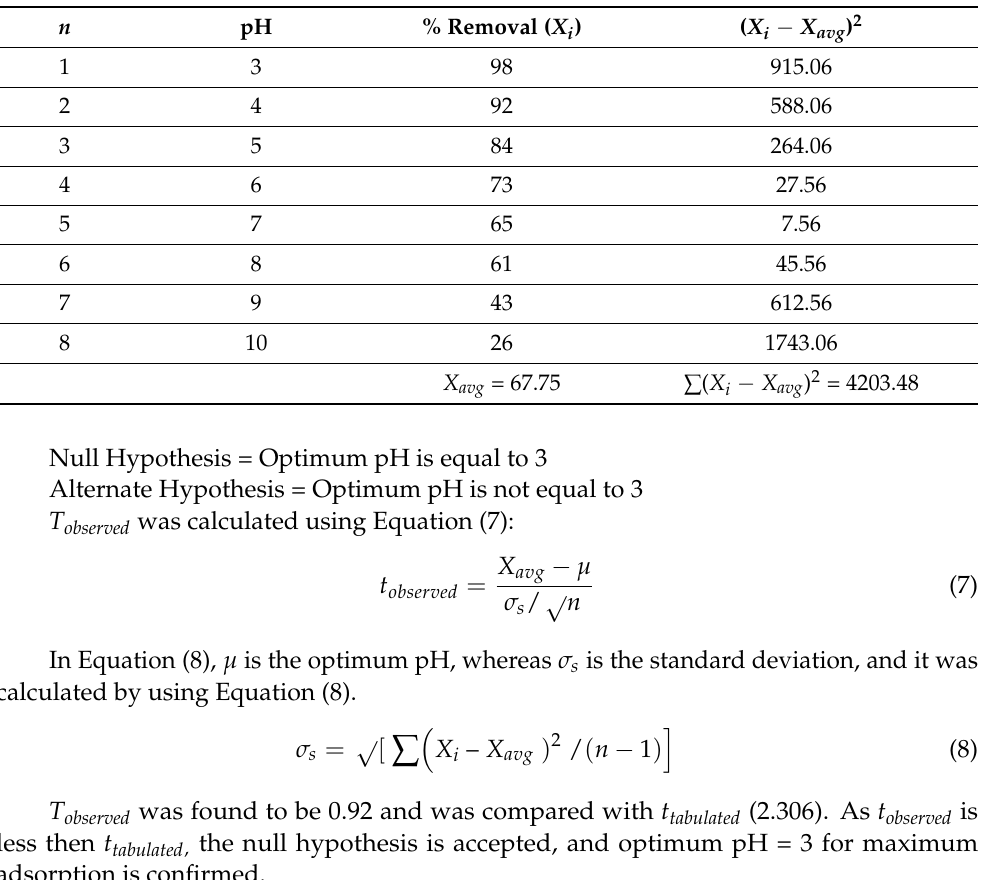
Table 2. Maximum removal of arsenic (III) at various pH.